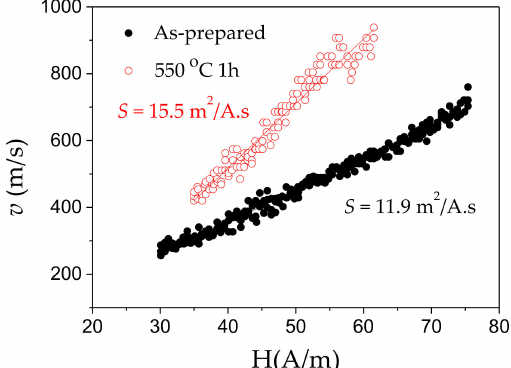
Figure 12. v(H) dependencies of as-prepared and annealed (550 ◦ C 1 h) Fe 71.7 B 13.4 Si 11 Nb 3 Ni 0.9 microwires. Reproduced from Ref. [45] with